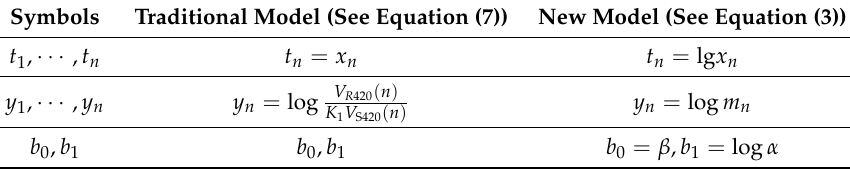
Table 2. Parameter description of traditional model and proposed